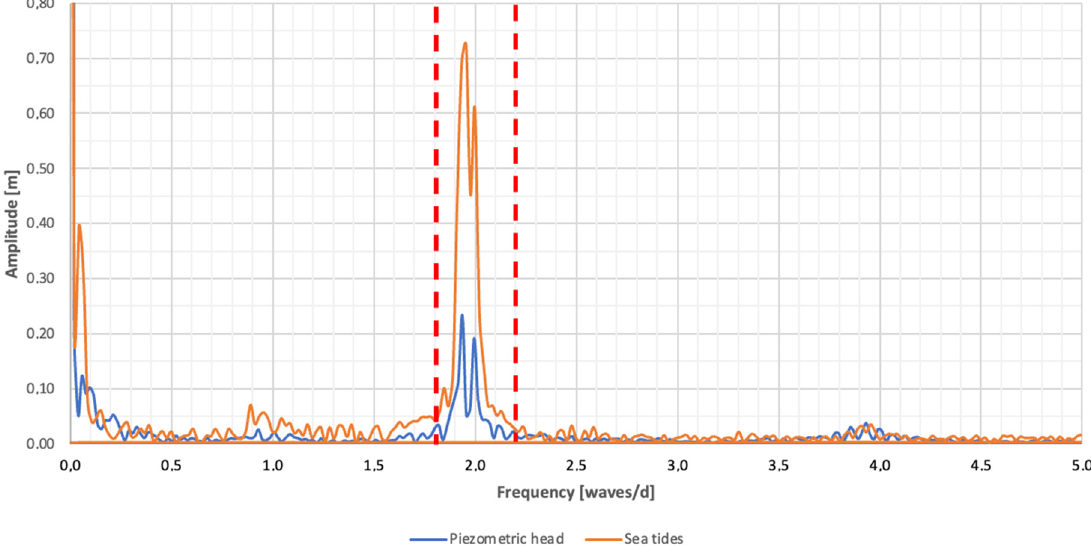
Figure 6. Plot of piezometric heads of Madliena gauging borehole and sea tides in spectral domain; the cut-off frequency range is shown in red dashed lines.